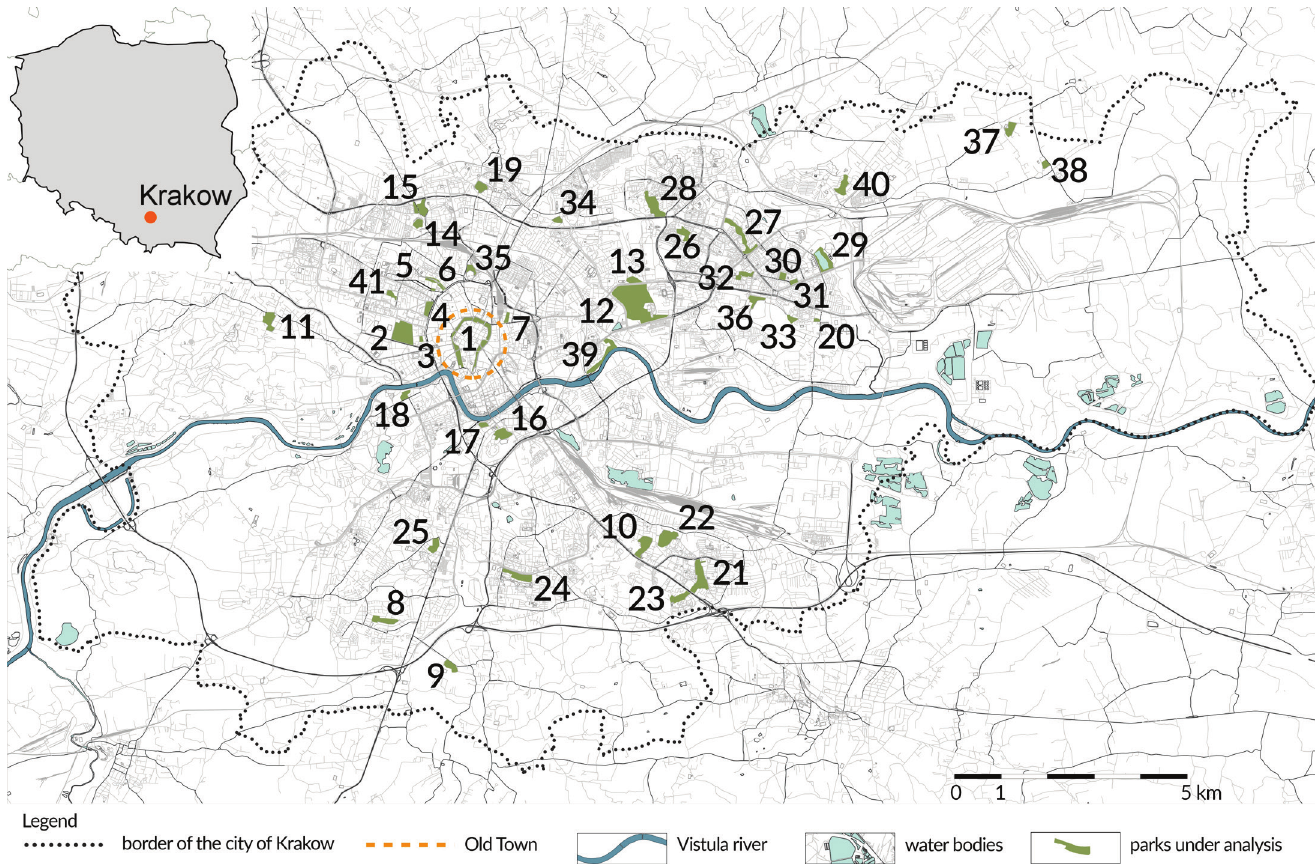
Figure 1. Distribution of the Krakow parks under study: 1.Krakow Plants, 2. Jordan Park, 3. Park nearby Jagiellonian Librery, 4. Krakowski Park, 5. Aksentowicz Park, 6. Młynówka Królewska Plants – east part, 7. Park Strzelecki, 8. Maćka i Doroty Park, 9. Zdrojowy Park in Swoszowice, 10. Jerzmanowskich Park, 11. Dębnicki Park, 12. Lotników Park – south part, 13. Lotników Park – north part, 14. Wyspiańskiego Park, 15. Krowoderski Park, 16. Bednarski Park, 17. Nowacki Plants, 18. Decjusz Park, 19. Kościuszki Park, 20. Park nearby Willa Rogozińskich in Mogila, 21 Aleksandry Park – south part, 22. Lilii Wenedy Park, 23. Rżąska Park, 24. Kurdwanowski Park, 25. Solvay Park, 26. Dywizjonu 303 Park, 27. Bieńczyckie Plants south part, 28. Millenium Park, 29. Zalew Nowohucki Park, 30. Ratuszowy Park, 31. Szwedzki Park, 32. Wiśniowy Sad Park, 33. Żeromskiego Park, 34. Zaczarowanej Dorożki Park, 35. Kleparski Park, 36. Kultury Park, 37. Park in Łuczanowice, 38. Wadów Park, 39. Dąbie Park, 40. Zielony Jar Park, 41. Park of saint Wincent